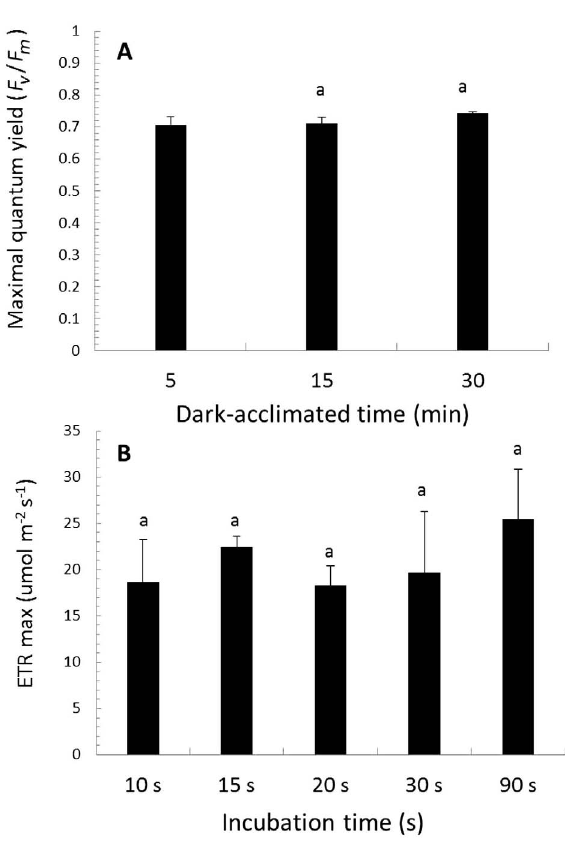
/F Fig. 2. – Measurement of maximum quantum yield ( F ) after v m incubation of C. tamariscifolia thalli in different time periods in darkness (5, 15 and 30 min) (A). Different incubation time (10, 15, 20, 30 and 90 s) under increased irradiances of actinic light (PAR) to estimate the ETR (B). max